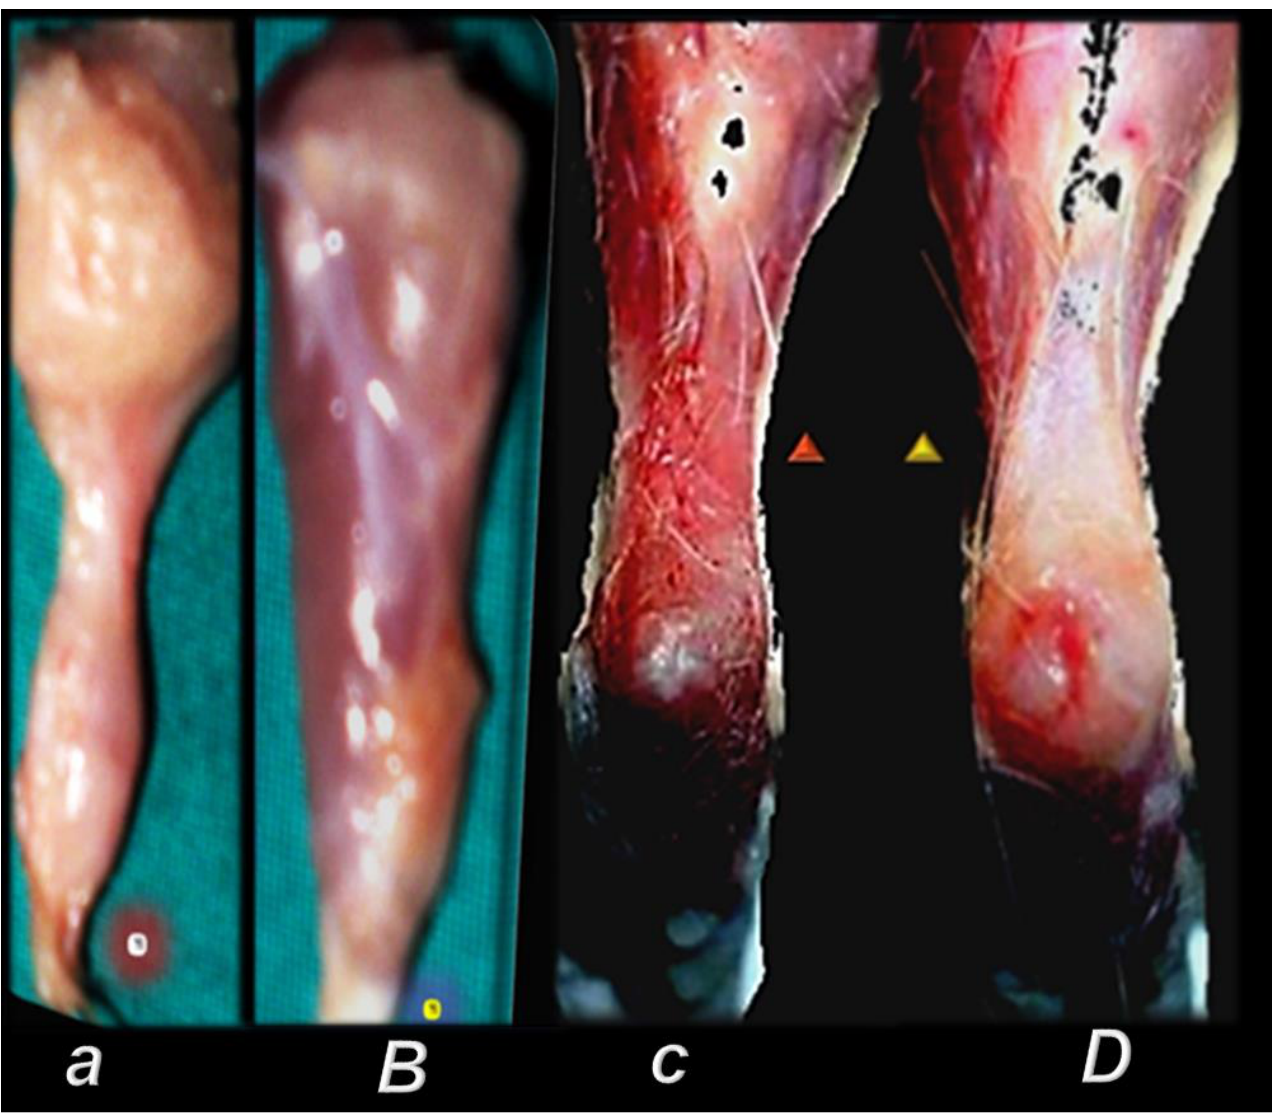
Figure 8. Gross presentation of the perilous course after major muscle transection (quadriceps muscle (circle indicates distal part of the muscle) ( a ) [44], and after the rat’s Achilles tendon was sharply transected from the calcaneal bone ( c ) [94] (triangle indicates significant gap between the tendon edge and bone with a clear stump). Injurious course (controls, small letters) was counteracted by pentadecapeptide BPC 157 (capitals). BPC 157 regimens (10 µg, 10 ng, 10 pg/kg, intraperitoneally, once daily) improved gross presentation (transected muscle, muscle presentation with regeneration and absent marked atrophy, at day post-surgery day 72 ( B ); detached tendon, no defect between the tendon stump and calcaneal bone. The edge of the tendon stump cannot be recognized (osteotendon junction re-established ( D )), and there is functional, biomechanical microscopical, immunohistochemistry healing